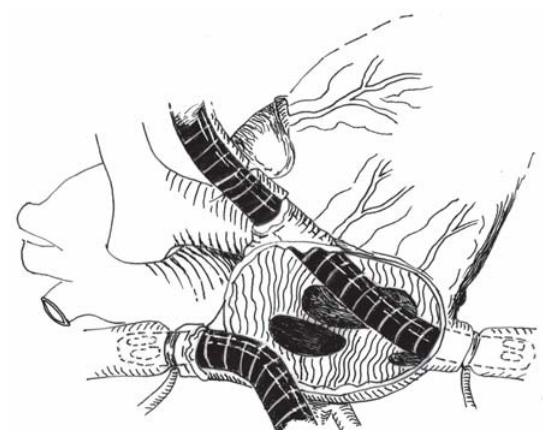
Fig. 2 - Canulação das duas veias cavas através da veia cava superior, permitindo procedimentos transtricuspídeos